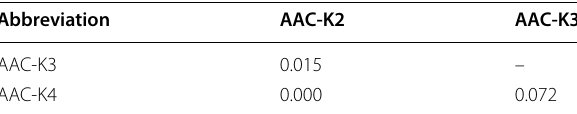
Table 3 Adjusted p value between each stake group